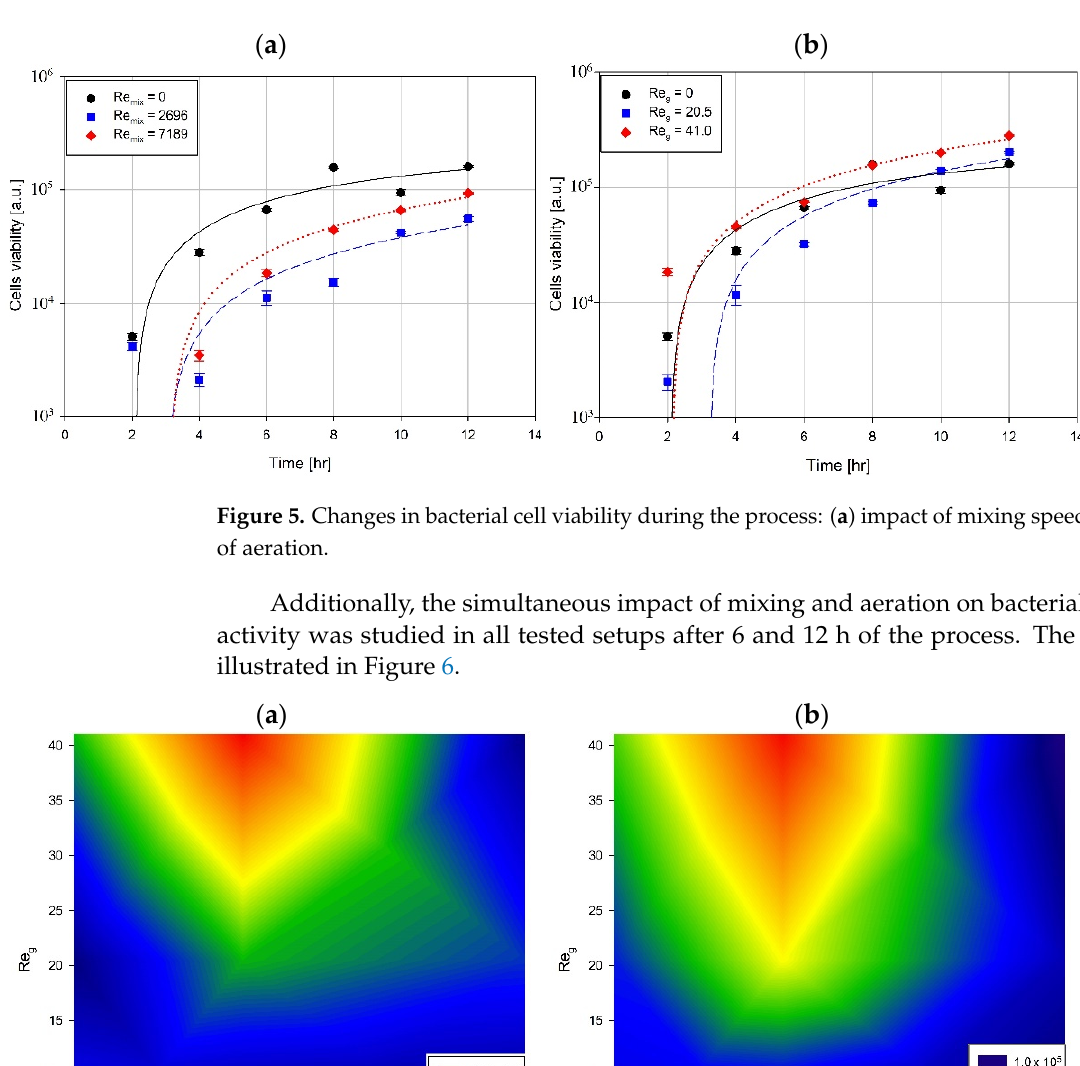
Figure 5. Changes in bacterial cell viability during the process: ( a ) impact of mixing speed, ( b ) im- pact of aeration.